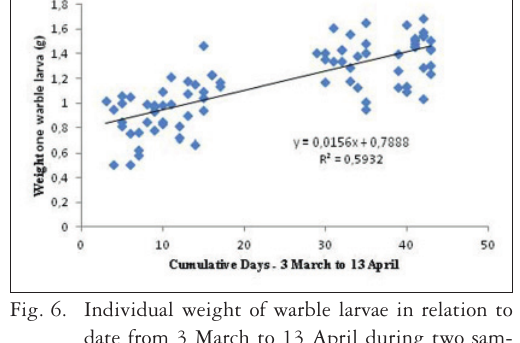
Fig. 6. Individual weight of warble larvae in relation to date from 3 March to 13 April during two sam- pling years (2008, 2009). Regression slope was significant ( P < 0.0001).